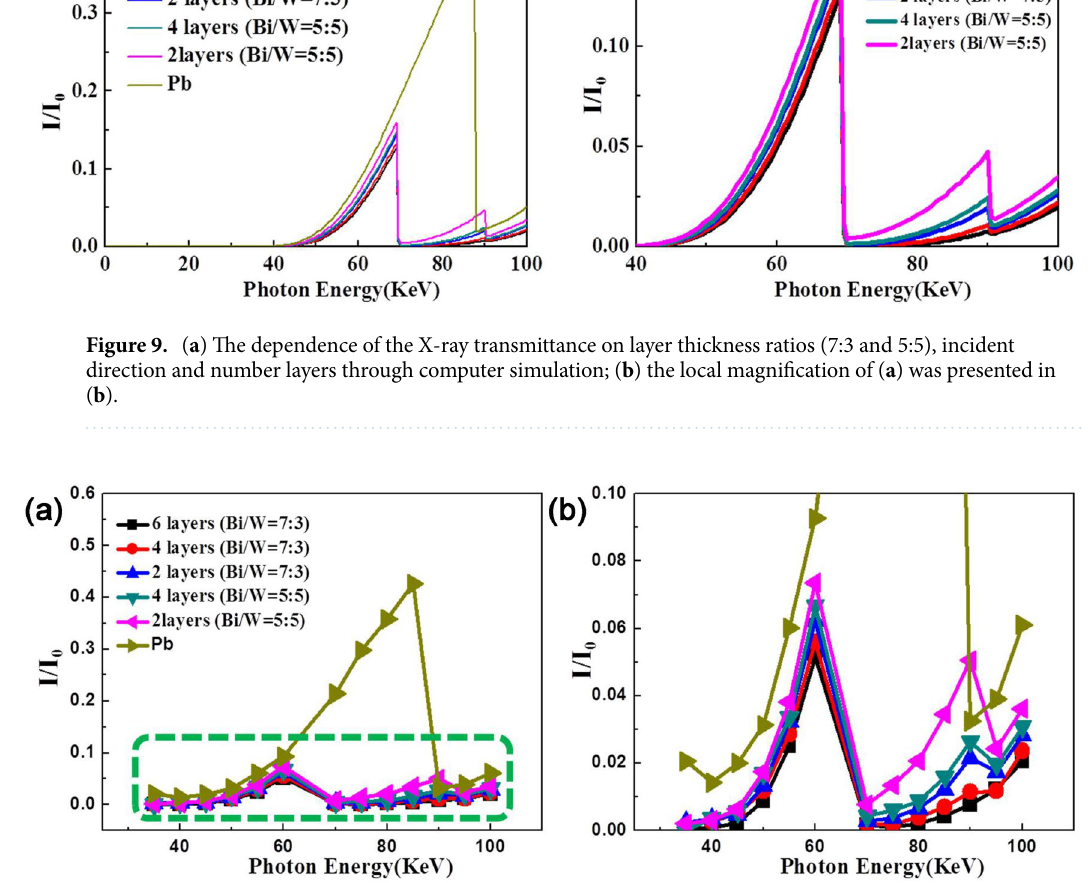
Figure 10. ( a ) The dependence of the X-ray transmittance on layer thickness ratios (7:3 and 5:5); the local magnification of ( a ) was also presented in ( b ).